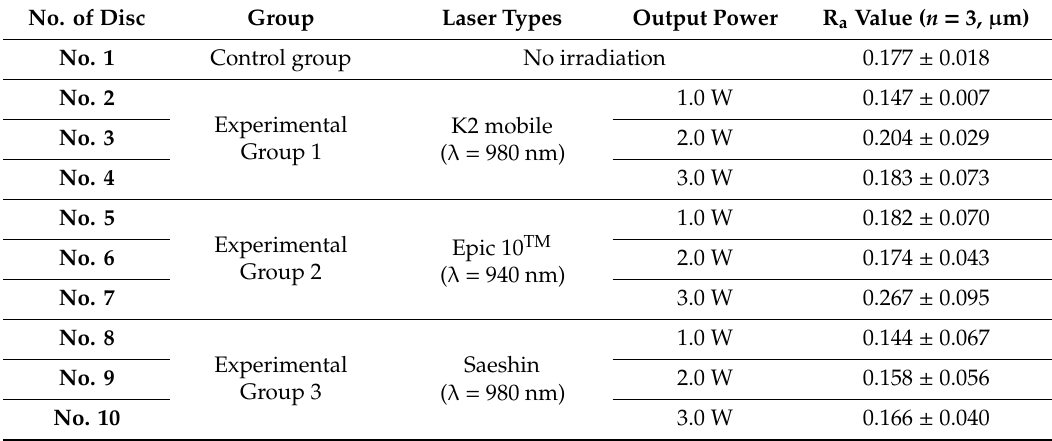
Table 3. Mean surface roughness (Ra) values of sandblasted and acid-etched (SLA) titanium implants under various laser types and output